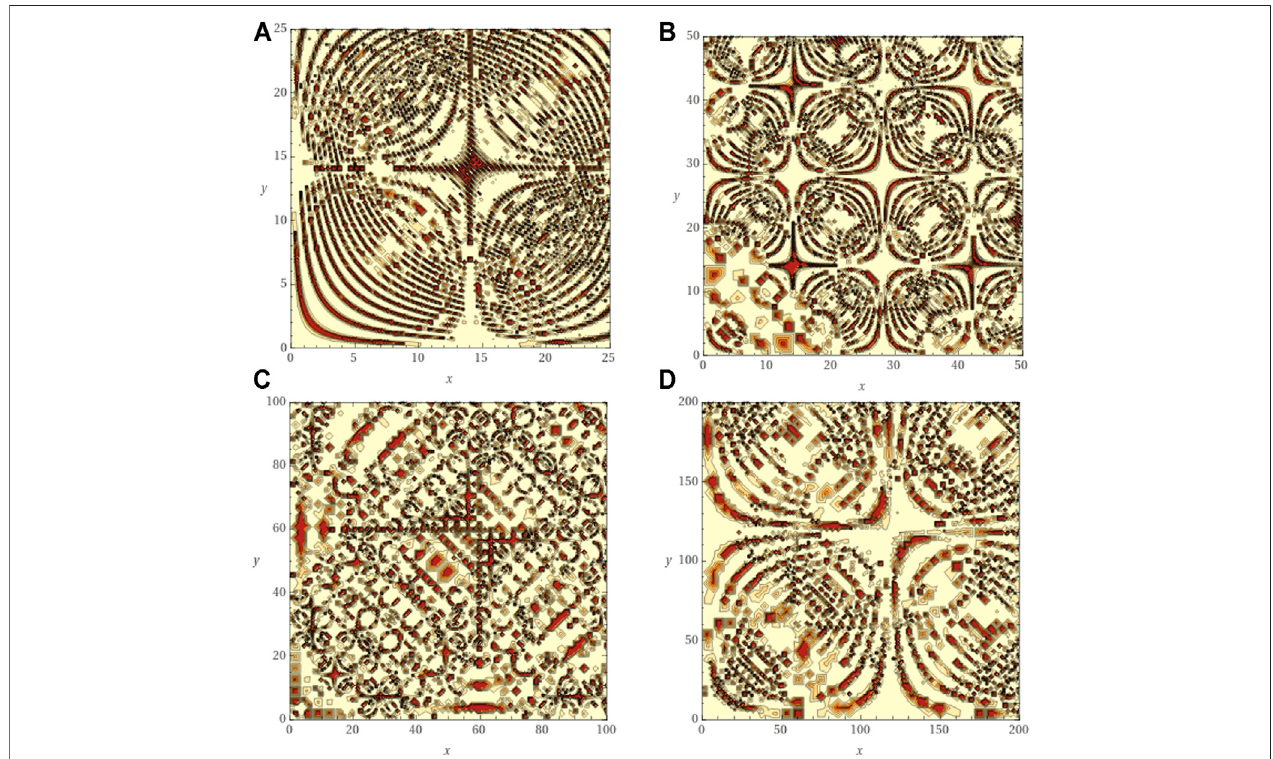
FIGURE 5 | Example 2D plot of h ( Ω , t ) , in this case x ≡ Ω , y ≡ t , in WolframAlpha; (A) maximum at 25; (B) maximum at 50, (C) maximum at 100, (D) maximum at 200.